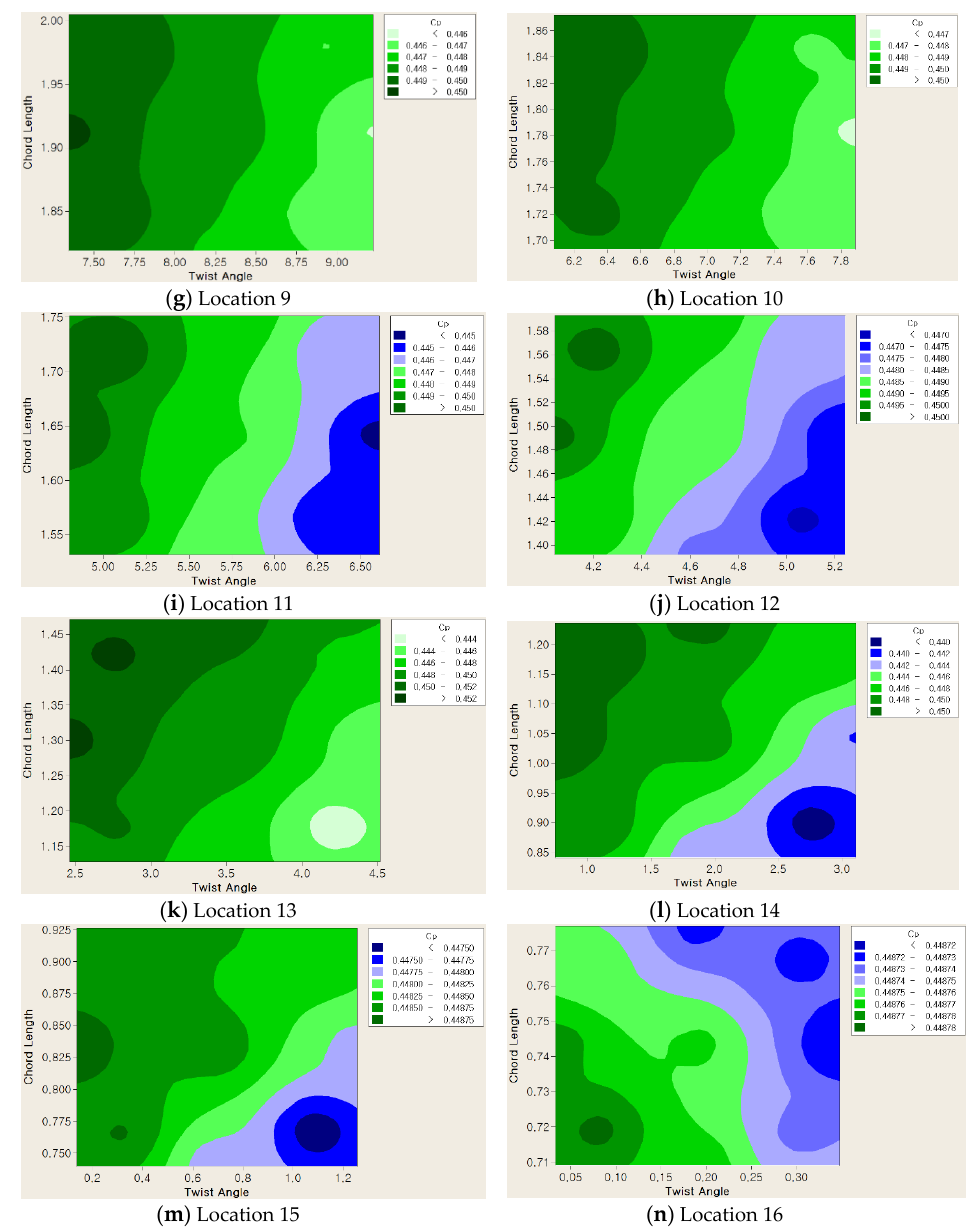
Figure 8. Contour plots of C P in terms of chord length and twist angle. ( a ) Location 3. ( b ) Location 4. ( c ) Location 5. ( d ) Location 6. ( e ) Location 7. ( f ) Location 8. ( g ) Location 9. ( h ) Location 10. ( i ) Location 11. ( j ) Location 12. ( k ) Location 13. ( l ) Location 14. ( m ) Location 15. ( n ) Location 16.